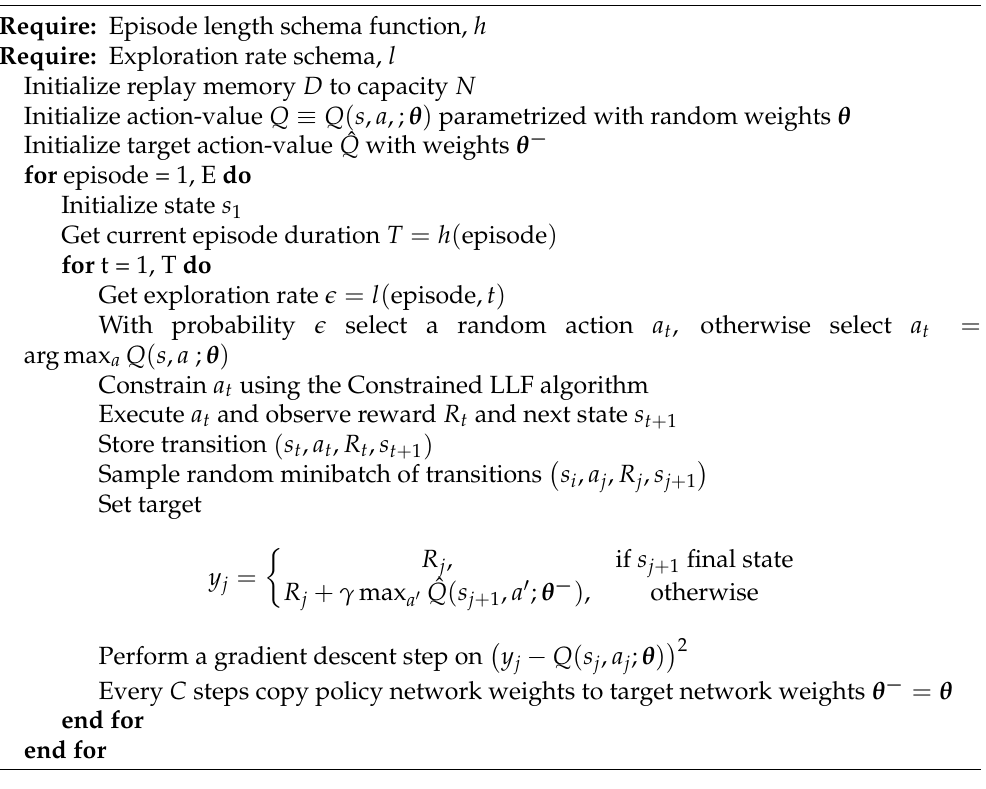
Algorithm 2 Constrained deep